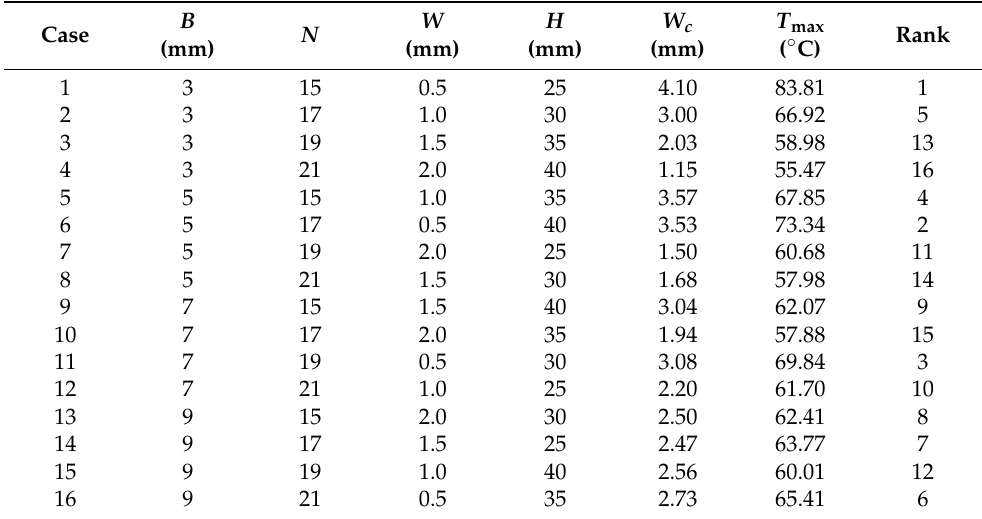
Table 4. Orthogonal design scheme and